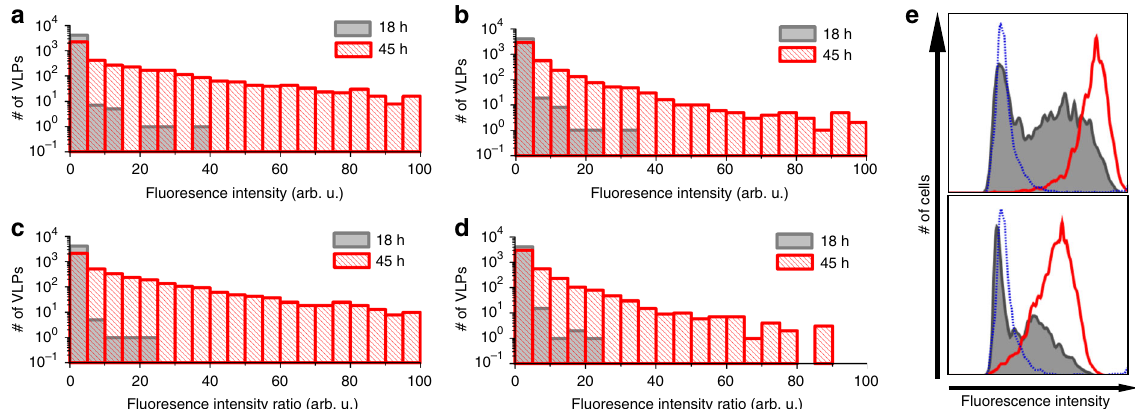
Fig. 4 The incorporation of the envelope glycoproteins is related to the cell surface expression levels, not the stoichiometry of F/M or G/M. VLPs described in Fig. 3h were subjected to confocal microscopy imaging. The VLPs were located by the GFP signal from M; the intensities of the F and G signals co- localized with M were analyzed. a , b Histograms of F ( a ) and G ( b ) incorporation levels in VLPs collected at 18 (gray) and 45 (red) h post transfection of F and G. c , d Histograms of F/M ( c ) and G/M ( d ) ratios in VLPs collected at 18 (gray) and 45 (red) h post transfection of F and G. e Expression levels of F (top) and G (bottom) in the GFP-positive and VLP-producing cells at 18 (gray) and 45 (red) h post tranfection. Cells expressing M alone were set as control (blue dotted line). Three independent experiments were